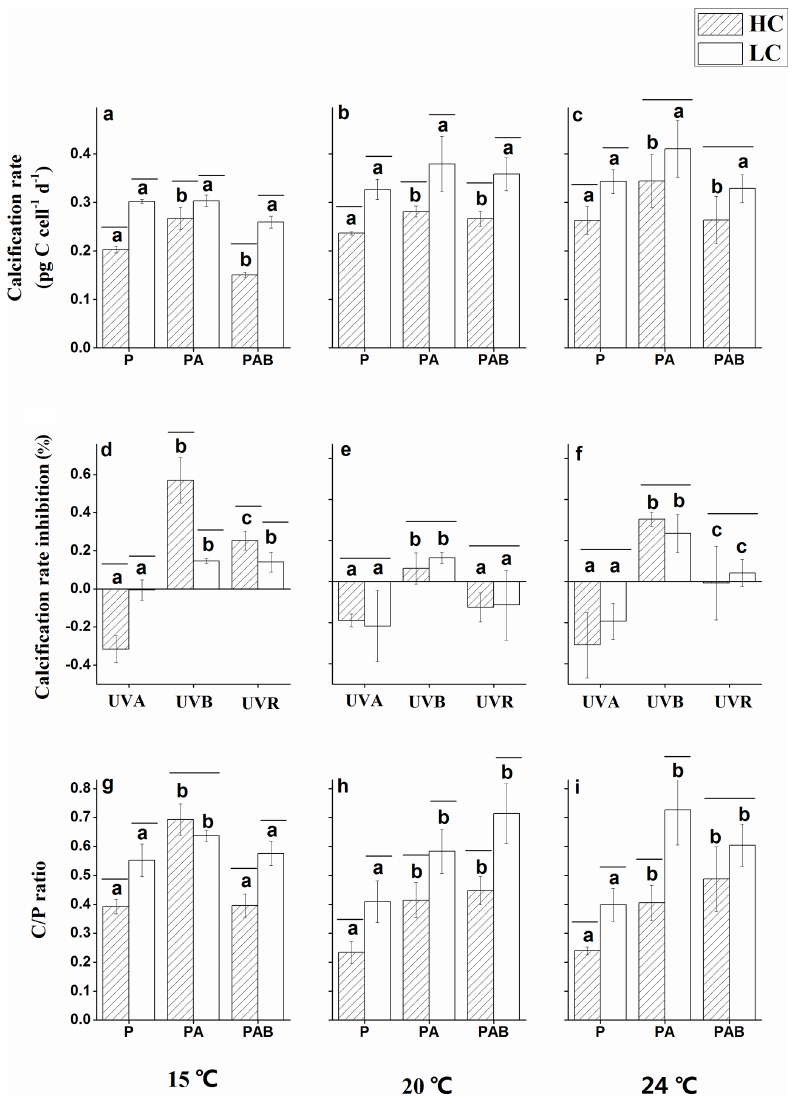
Figure 6. Calcification rates under P, PA and PAB (a–c) ; inhibition of calcification rates due to UVA, UVB and UVR (d–f) ; and Cal / Pho ratios under P, PA and PAB (g–i) for E. huxleyi in HC- and LC-grown cells at 15, 20 and 24 ◦ C. Negative inhibition values indicate stimulation. Lines above the histogram bars indicate significant differences between the HC and LC treatments, and the different letters indicate significant differences among the radiation treatments within the HC or LC-grown cells within each